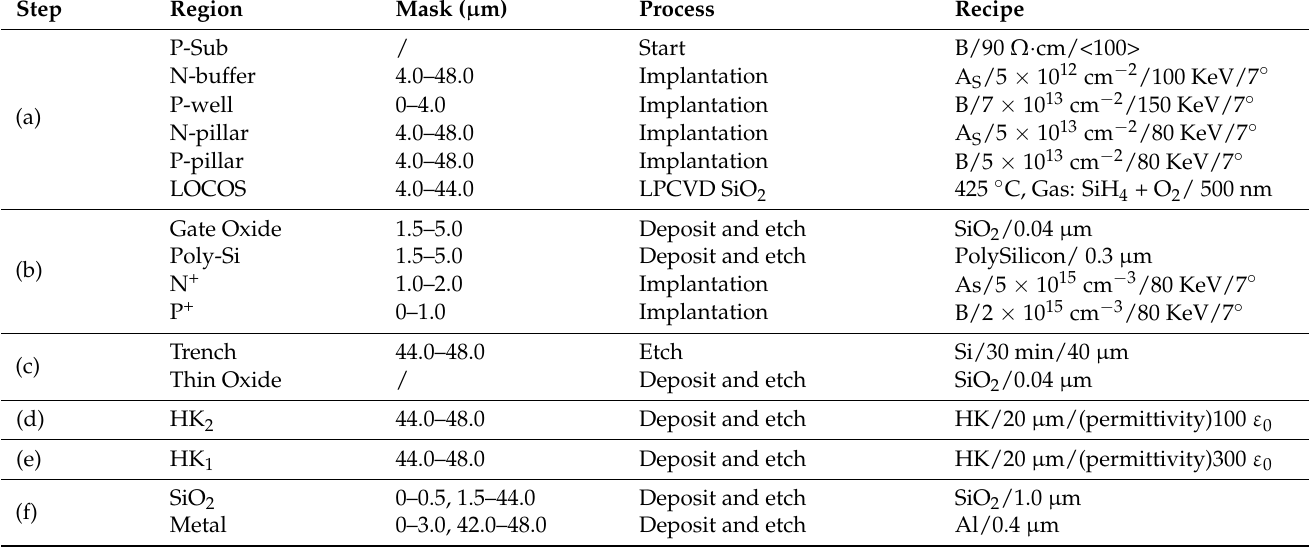
Table 2. Key parameters in the